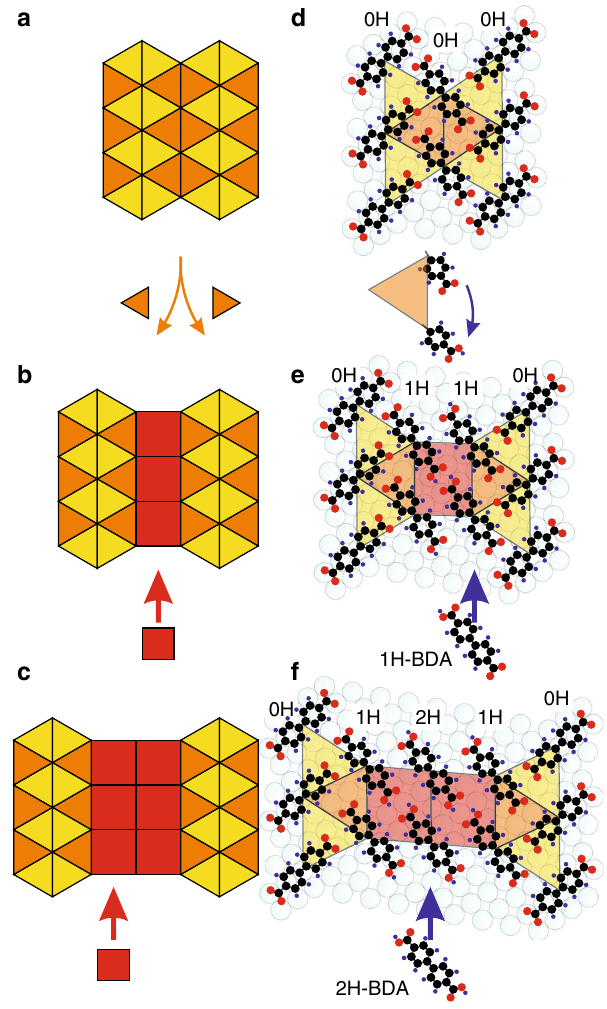
Fig. 4 The increase of tessellation complexity by inserting new tiles and binding motifs. a – c The 2-uniform tiling ( b ) is obtained by inserting a square tile between the rows of orange triangles of regular tiling ( a ). Likewise, insertion of an additional square results in the 3-uniform tiling ( c ). d – f Tentative molecular models based on LEED and STM data with colored tiles in the background. C: black, O: red, H: blue. Vertical rows of 0H-, 1H-, and 2H-BDA are marked by an inscription 0H, 1H, and 2H,